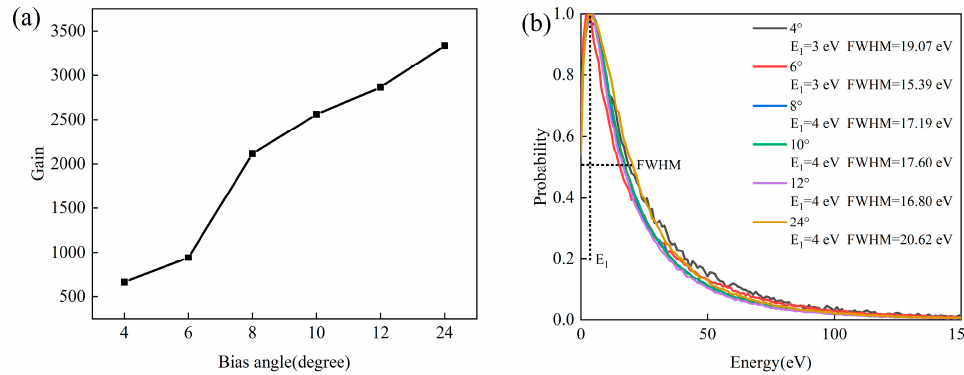
Figure 8. Effect of the bias angle on secondary electron multiplication (bias voltage = 900 V, L / D = 39, l 2 = 16 μ m): ( a ) Gain; ( b ) The most probable exit energy distribution.